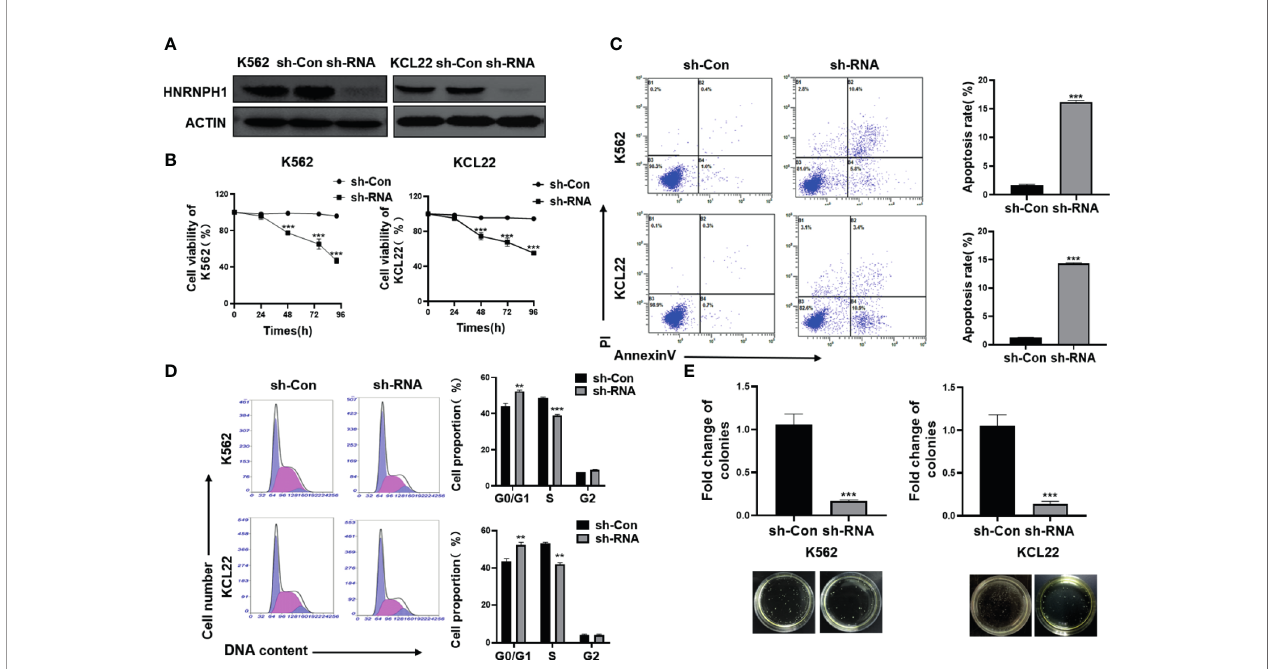
FIGURE 2 | HNRNPH1 downregulation promotes apoptosis of CML cells. (A) K562 and KCL22 cells were transfected with speci fi c sh-RNA of HNRNPH1 or negative sh-RNA (sh-Con). Western blot was used to detect HNRNPH1 protein level. (B) CML cells were prepared as (A) , CCK-8 analysis was used to detect cell proliferation. ***P < 0.001 vs. sh-Con. **P < 0.01 vs. sh-Con. (C) CML cells were prepared as (A) , and cell apoptosis rate was detected by fl ow cytometry using Annexin V-FITC/PI staining. The right panel shows the apoptosis rate from three independent experiments. ***P < 0.001 vs. sh-Con. (D) CML cells were prepared as (A) , and the cell cycle was detected by fl ow cytometry. The right panel shows the cell proportion of three independent experiments. **P < 0.01 vs. sh-Con. (E) CML cells were prepared as (A) , and cell proliferation was detected by colony formation assay. ***P < 0.001 vs. sh-Con. The bottom panel shows an image of